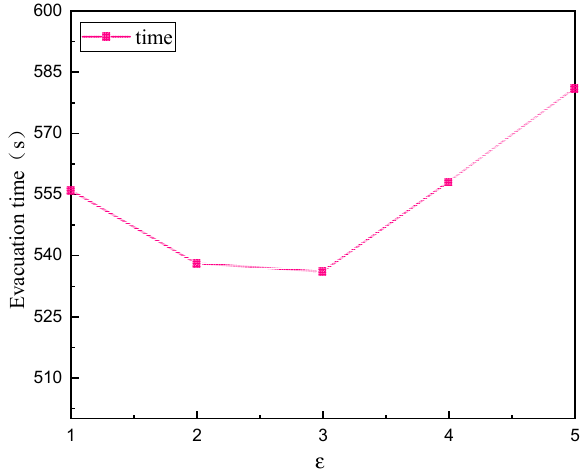
Figure 10. Effects of number of ants placing pheromone ω on evacuation time.